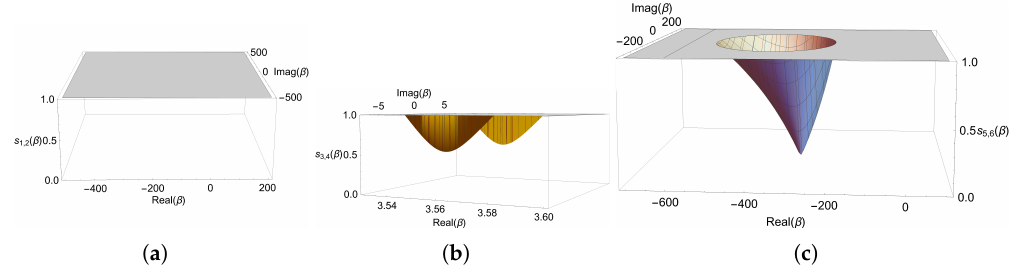
Figure 2. Strange fixed points s j p β q , j “ 1, . . . ,6. ( a ) s 1 p β q and s 2 p β q . ( b ) s 3 p β q and s 4 p β q . ( c ) s 5 p β q and s 6 p β q